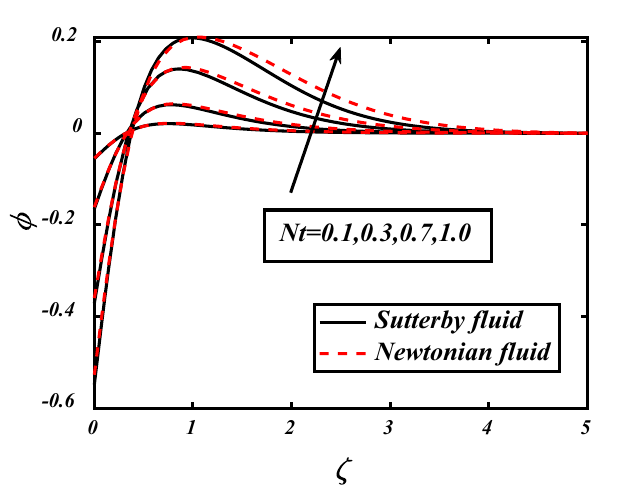
Figure 13. expounds the impacts of Nt on φ